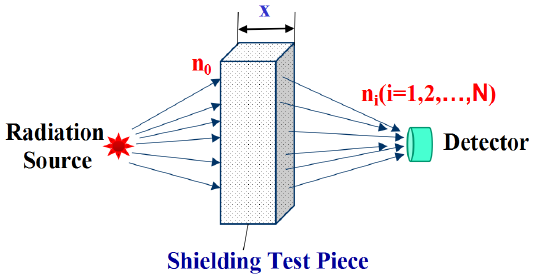
Figure 11. Schematic diagram of the experimental model used for gamma-ray attenuation.